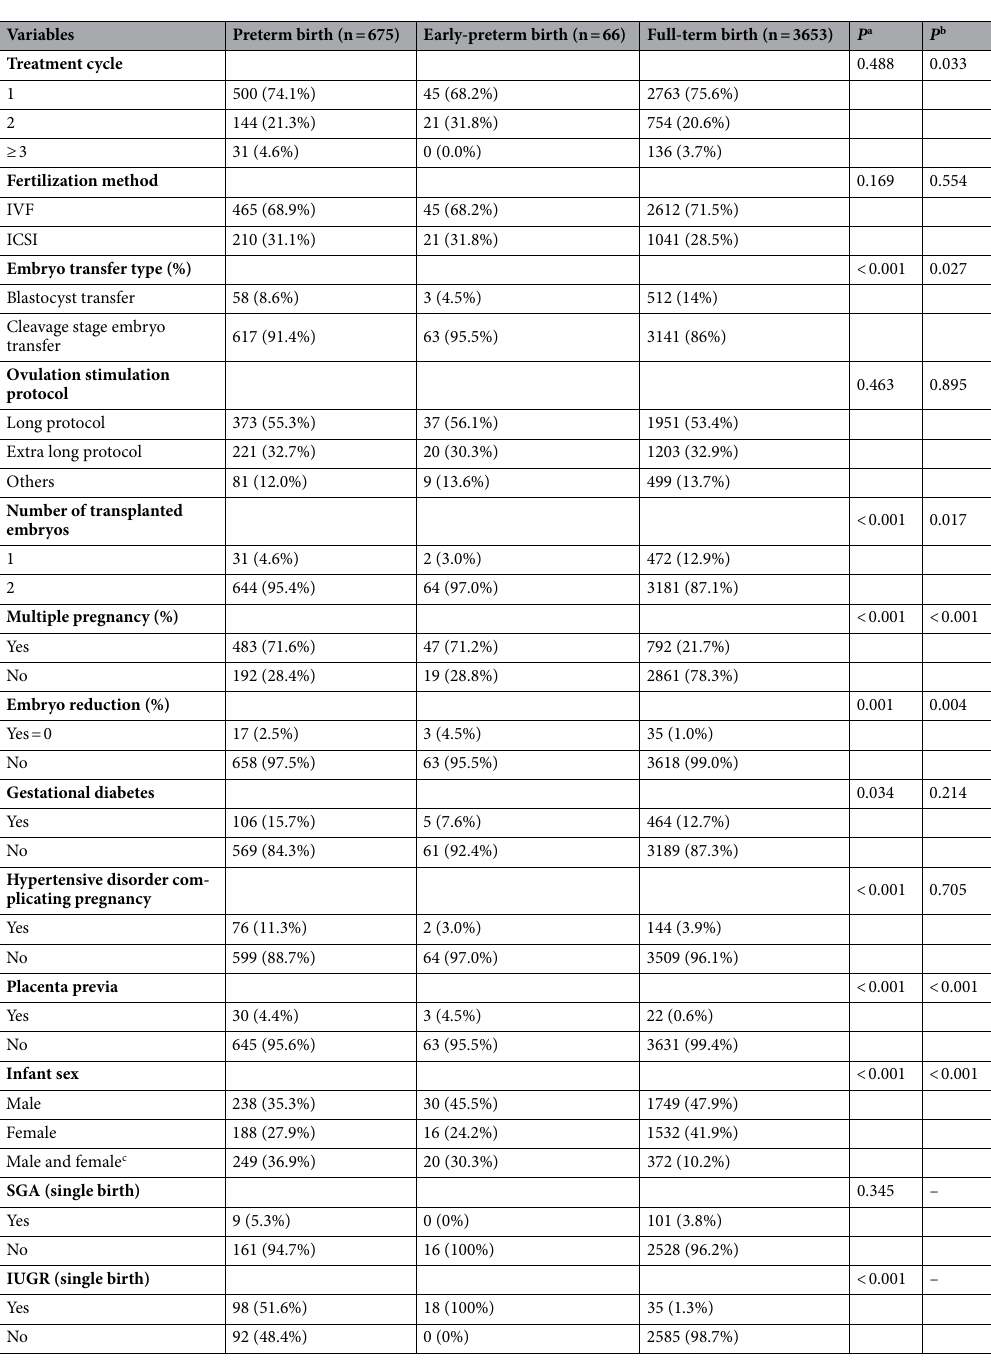
Table 3. Pregnancy factors after embryo implantation was compared between preterm birth group and full- term birth group. SGA mall for gestational age, IUGR intrauterine growth retardation. a Preterm birth group vs. full-term birth. b Early-preterm birth group vs. full-term birth. c In the multiple pregnancy, one is female infant, another is male